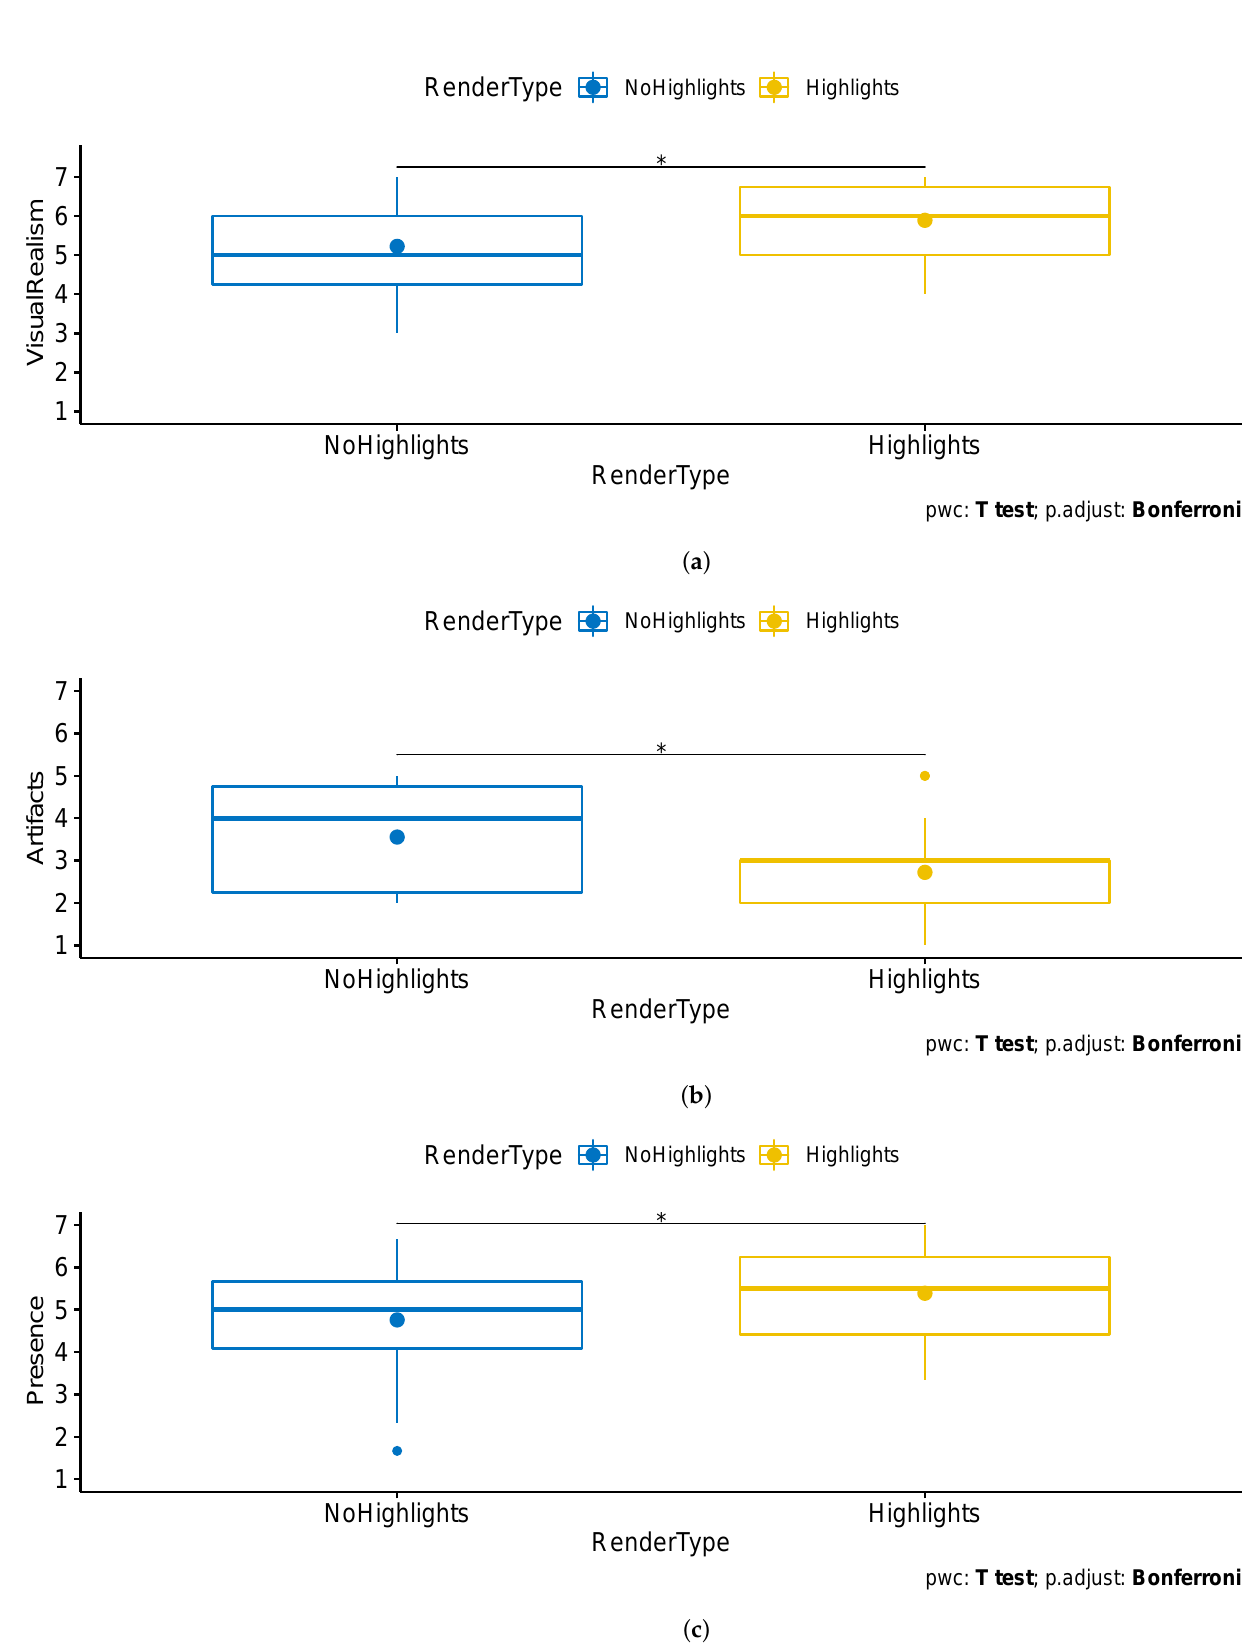
Figure 8. In the “Museum” scene, the following were shown to significantly differ based on rendering type: ( a ) visual realism (higher is more realistic); ( b ) perception of artifacts (higher is less disturbing); ( c ) presence (higher is